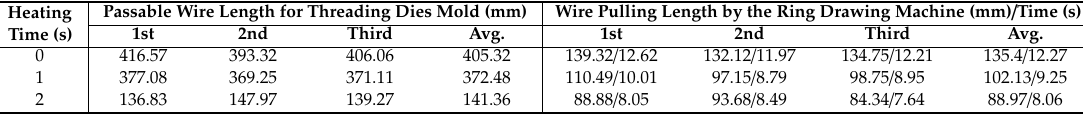
Table 17. Results based on wire pulling speed: k6(11.04 mm / s).